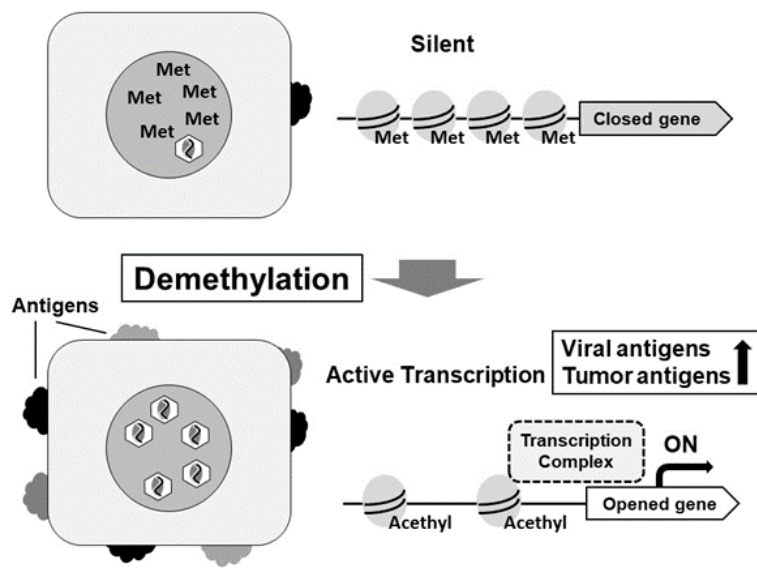
Figure 3. Treatment by DNA demethylating agents for EBVaGC.